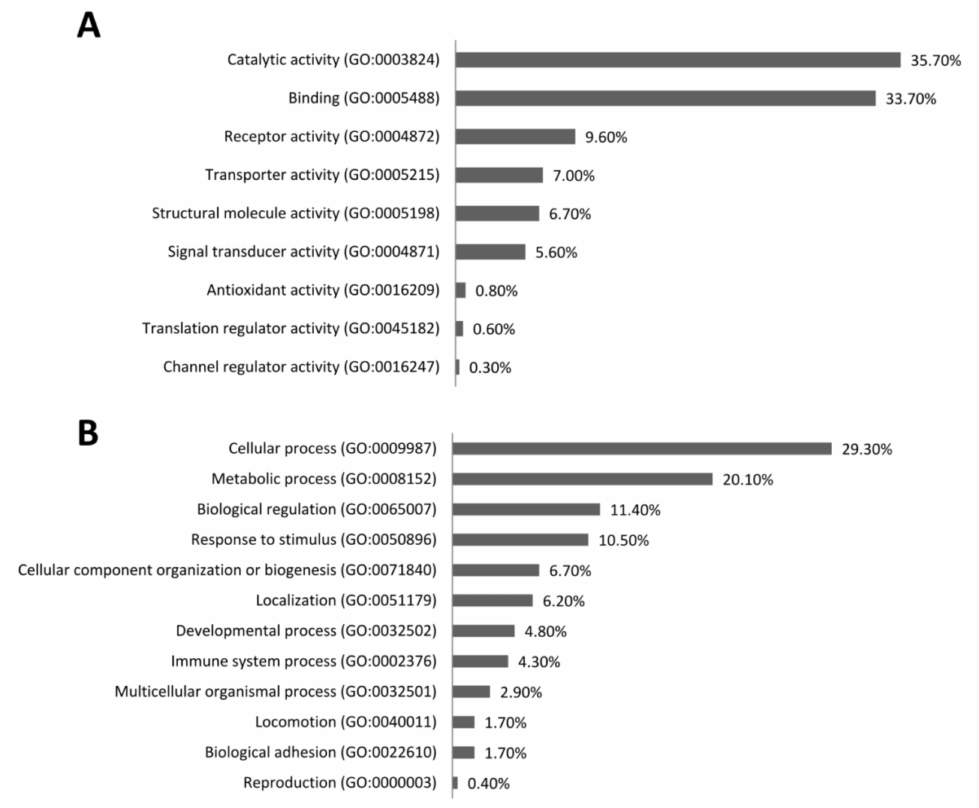
Figure 4. Gene Ontology (GO)-terms. Results refer to genes differentially expressed in animals fed the L and H diets. The analysis shows significantly enriched terms for ( A ) molecular functions and ( B ) biological